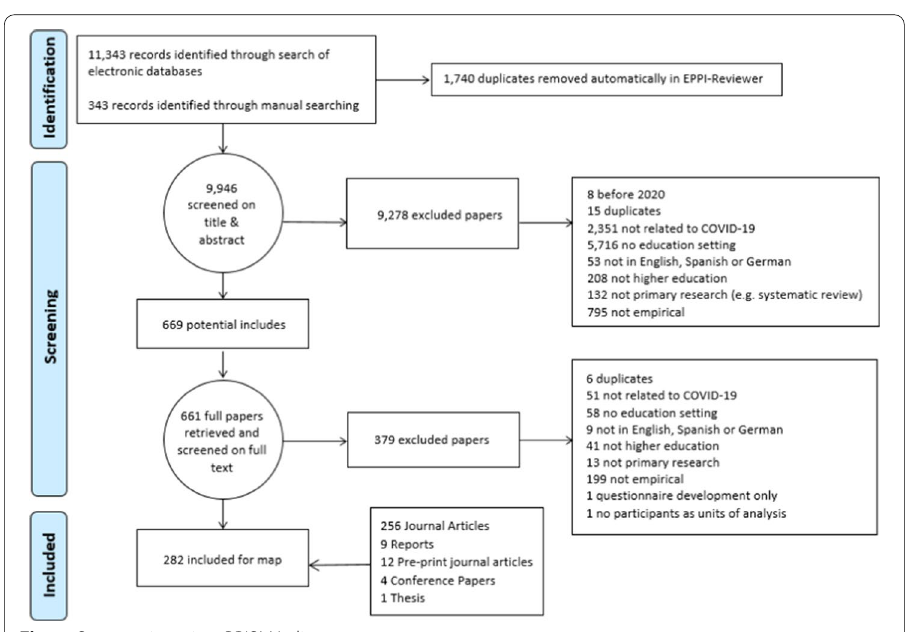
Fig. 1 Systematic review PRISMA diagram